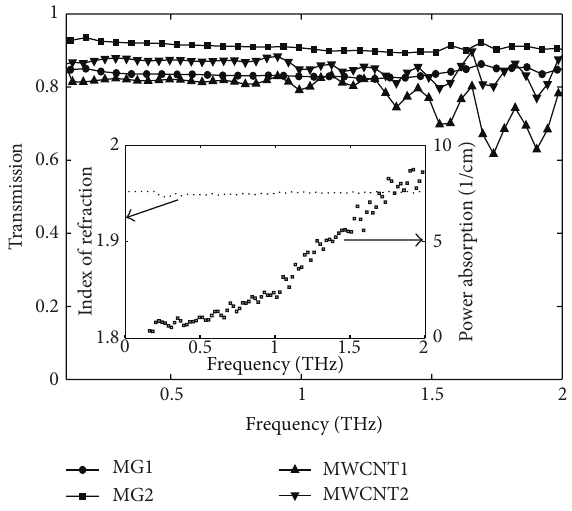
Figure 2: THz pulses transmitted through MWCNT and MG samples. The inset shows the optical properties of noncovered fused quartz at THz